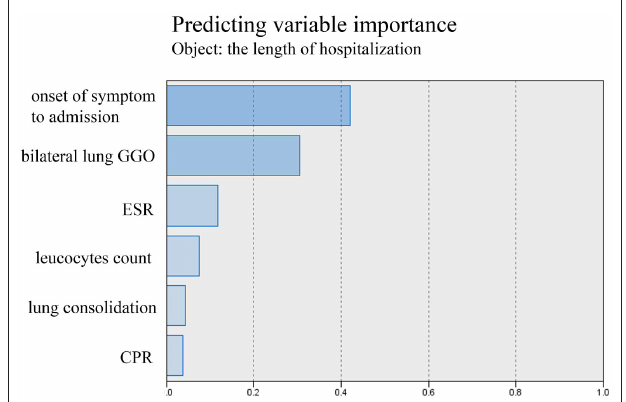
FIGURE 4 | Using automatic linear modeling to predict relevant factors of the length of symptoms